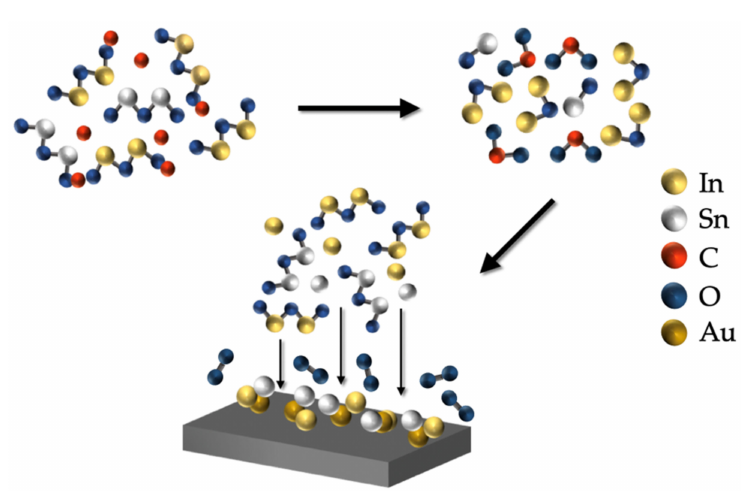
Figure 7. Schematic illustration of the growth mechanism of ITO NW, where the reaction follows the VLS